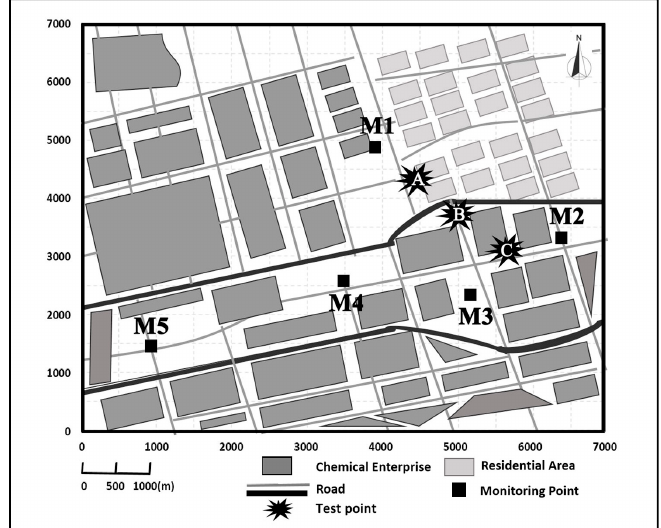
Figure 1. Locations of monitoring stations and test